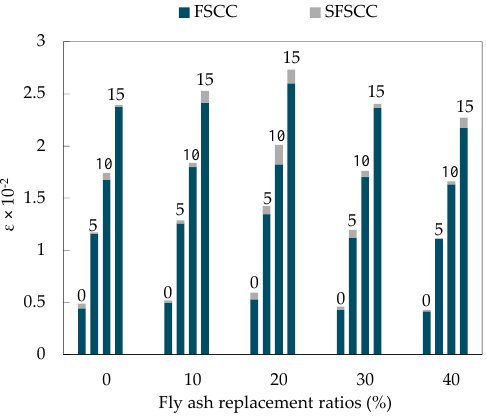
Figure 15. Peak strain of SCC under different confining pressures.